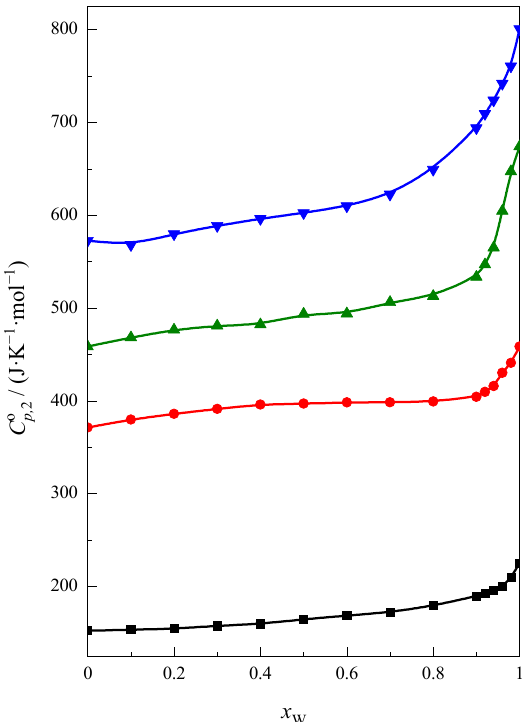
Figure 2. The standard partial molar heat capacity of cyclic ethers: ■ , 1,4-dioxane, ● , 12C4, ▲ , 15C5, ▼ , 18C6, as a function of x W in the F + W mixture at 298.15 K. As seen in Figure 2 the courses of curves are similar for 1,4-dioxane, 12C4 and 15C5. These shapes can be divided into two areas. First, with small and medium water content ( x W < 0.9) and second, with a high-water content in the F + W mixture ( x W ≥ 0.9). In the first area a linear, very small increase in the standard partial molar heat capacity of cyclic ethers with increasing of a water content in the mixture is observed. For 18C6, the shape of this curve is slightly different from the others in the range of 0.1 > x W > 0.7. In the area of high formamide content ( x W < 0.1), the small decrease of the standard partial molar heat capacity with the increasing water is observed. It suggests that 18C6 interacts in a specific way with formamide. In the literature [35,36] the crystal structure of the 1:2 complex of 18C6 molecule with formamide molecules is described. There are reports on the formation of complexes of 18C6 in solution with solvents such as: nitromethane, acetonitrile, chloroform or acetone [37]. Analyzing the distribution of the charges on hydrogen atoms in formamide, charge is the highest. Therefore, it can be assumed that such complexes between the